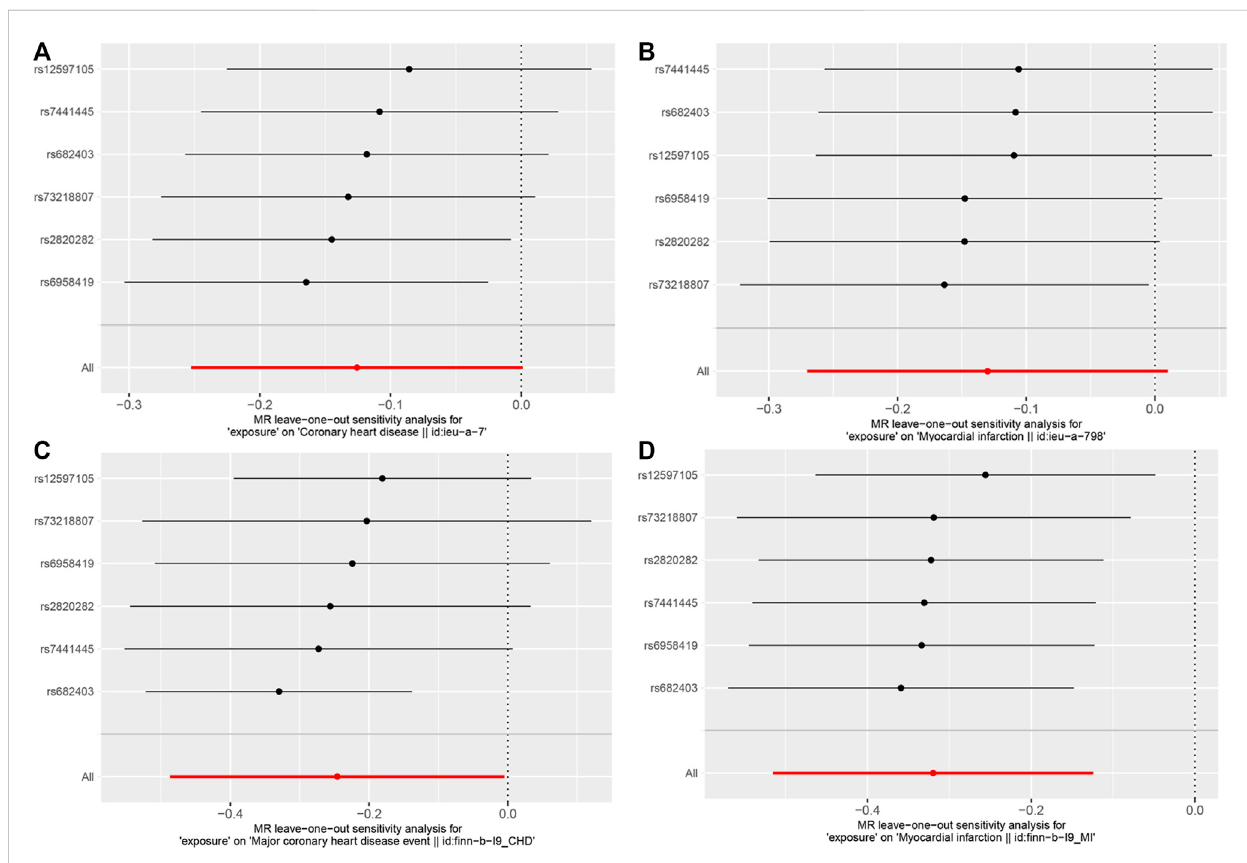
FIGURE 5 Resultsoftheleave-one-outanalysis. (A) .Theleave-one-outanalysisforRuminococcusUCG010onCADbasedonCARDIoGRAMplusC4D. (B) .The leave-one-out analysis for RuminococcusUCG010 on MI based on CARDIoGRAMplusC4D. (C) . The leave-one-out analysis for RuminococcusUCG010 on CAD based on FinnGen. (D) . The leave-one-out analysis for RuminococcusUCG010 on MI based on